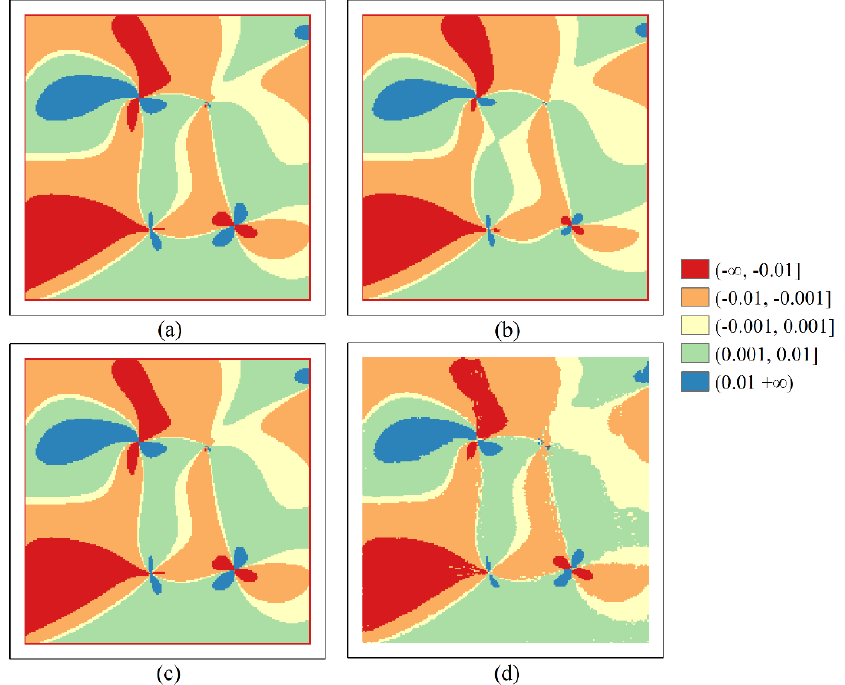
Figure 12. Spatial distribution of the residuals of the simulated C values relative to the theoretical C values on G3 for the: ( a ) Evans, ( b ) Zevenbergen, ( c ) Shary, and ( d ) FPN-based methods.